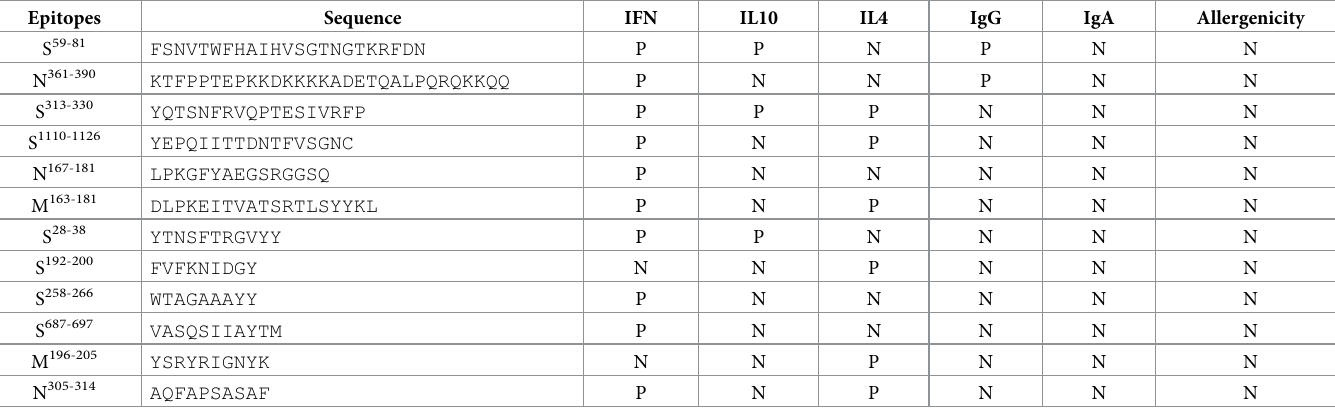
Table 2. Prediction of antibody-specific and cytokine inducer epitopes.